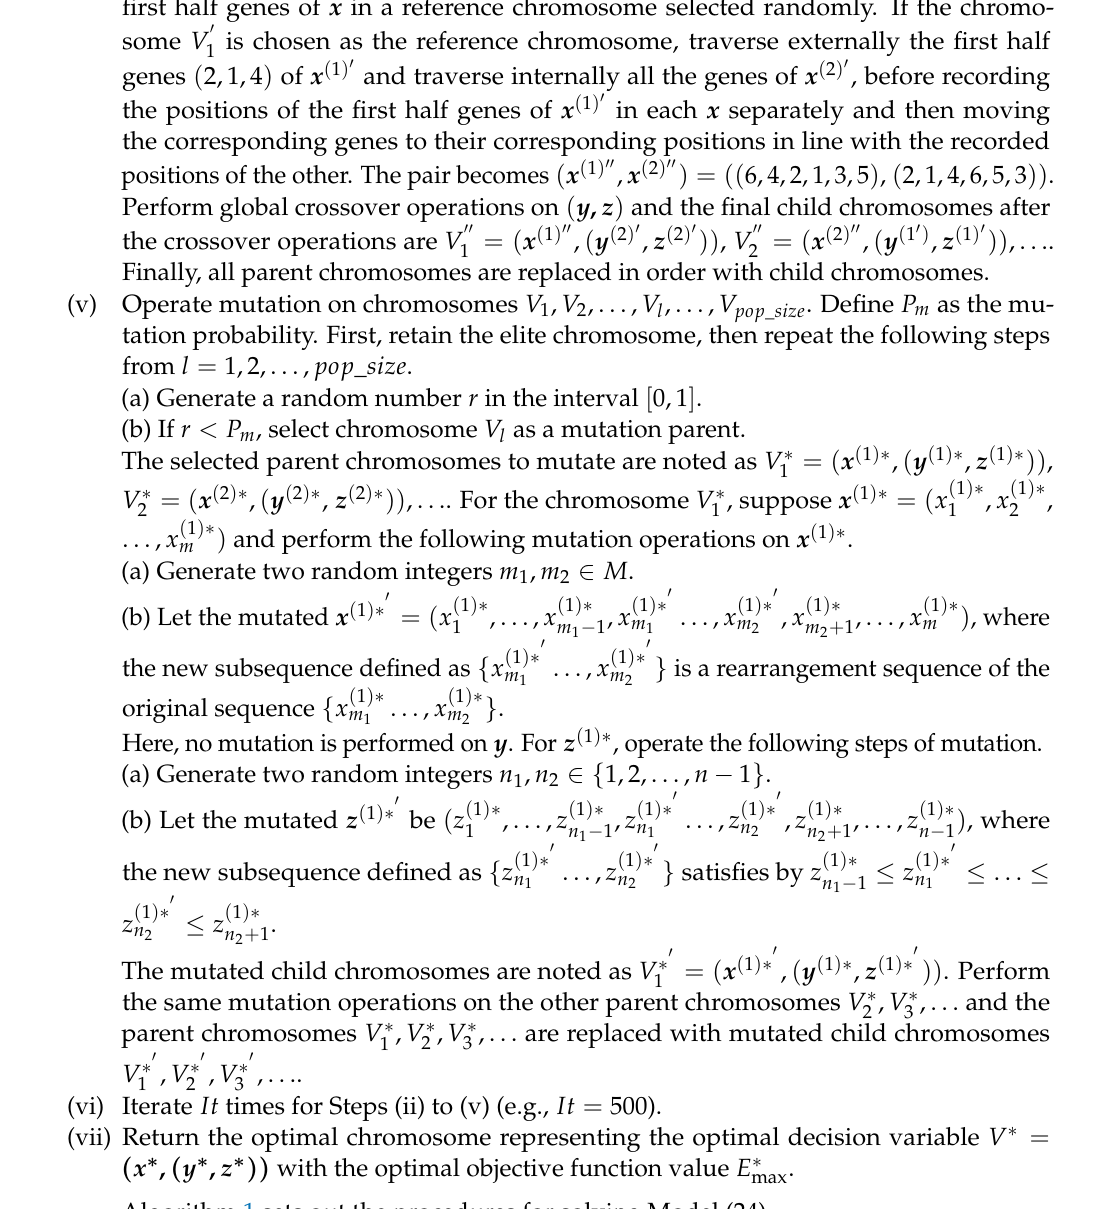
Algorithm 1 sets out the procedures for solving Model